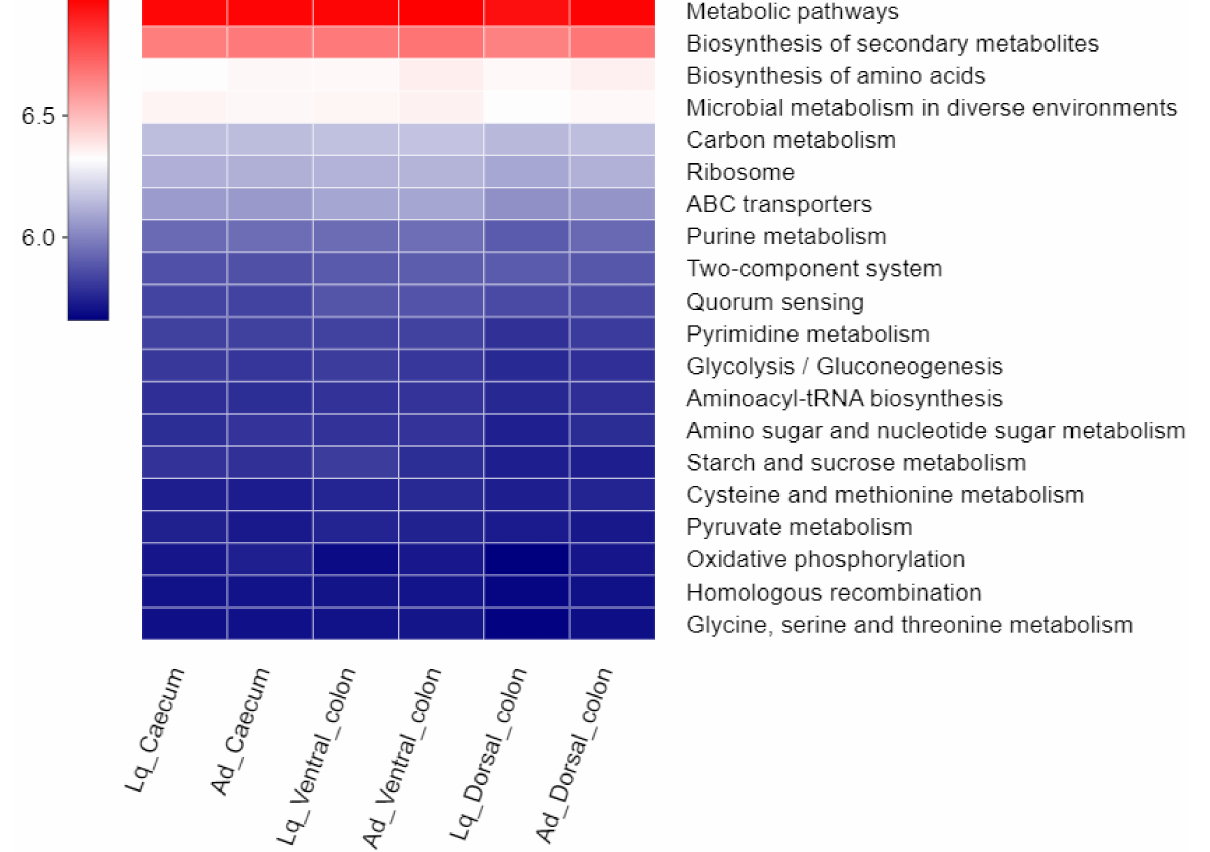
Figure 5. Variation in bacterial function profiles analyzed by PICRUSt. Each row in the heatmap represents a KEGG pathway, each column represents a treatment group. The color gradient in the graph indicates the functional abundance of the KEGG pathway in different treatment